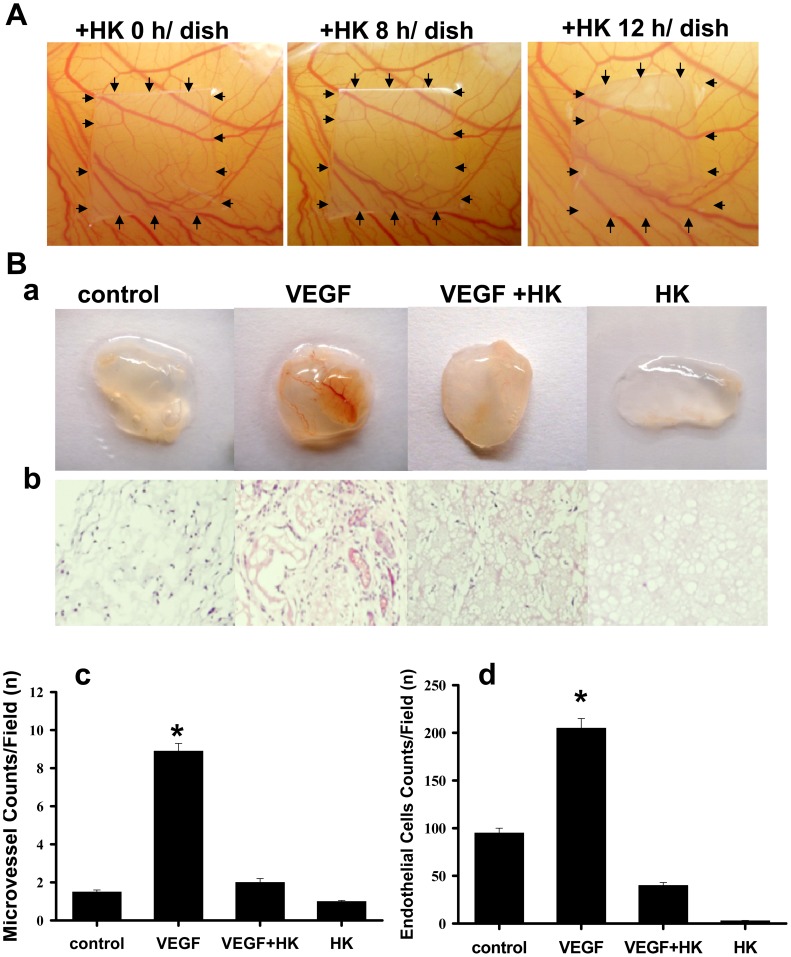
Effect of honokiol on angiogenesis.(A) Chorioallantoic membrane assay (CAM assay) was performed. Neovascular formation entrapped in type I collagen gels with or without honokiol (HK, 20 µM) treatment was examined. After 24-h incubation, the area around the loaded disk was photographed. (B) Matrigel (0.6 ml) was implanted subcutaneously in nude mice with or without honokiol (10 µg/ml) or VEGF (100 ng/ml). The injected matrigel rapidly formed a single solid gel plug. After 21 days, mice were sacrificed and matrigel plugs were excised. Representative matrigel plugs (a) and IHC for CD31 staining of sections from matrigel plugs (b) are shown. Quantifications of vessel numbers (c) and endothelial cells (d) in matrigel plug sections (counts/field) were calculated. The numbers in each case are the average from five different slides and five regions per slide. All data are presented as mean ± SEM (n = 8–10). *p<0.05 as compared with control.